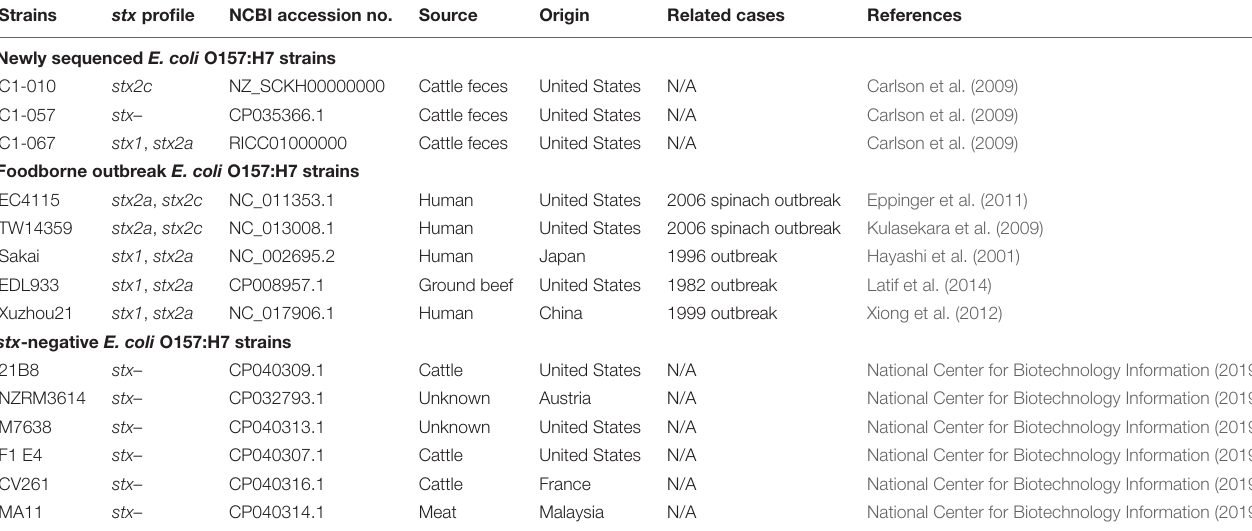
TABLE 1 | The stx gene profiles, accession numbers, sources, and countries of origin of the Escherichia coli O157:H7 strains used in this study.